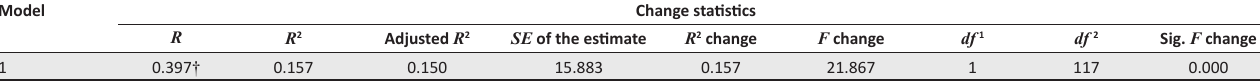
TABLE 6: Model summary of regression analysis with trait emotional intelligence as dependent variable and satisfaction as independent variable. Model